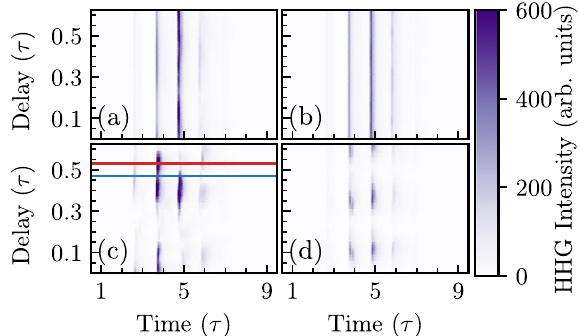
Figure 4. ( a )–( d ) Attosecond XUV bursts generated in the interaction for four different configurations of the 2 ω 0.5 , p-polarized, ( b ) a 2 ω 0.5 , s-polarized, ( c ) a 2 ω 5 , p-polarized and second harmonic ( 2 ω ) pulse, ( a ) a 0 = 0 = 0 = 2 ω 5 , s-polarized. The color axis represents the attosecond burst intensity in arbitrary units. A Chebyshev ( d ) a 0 = type-I digital filter is applied to obtain contribution between the 8th and the 45th order